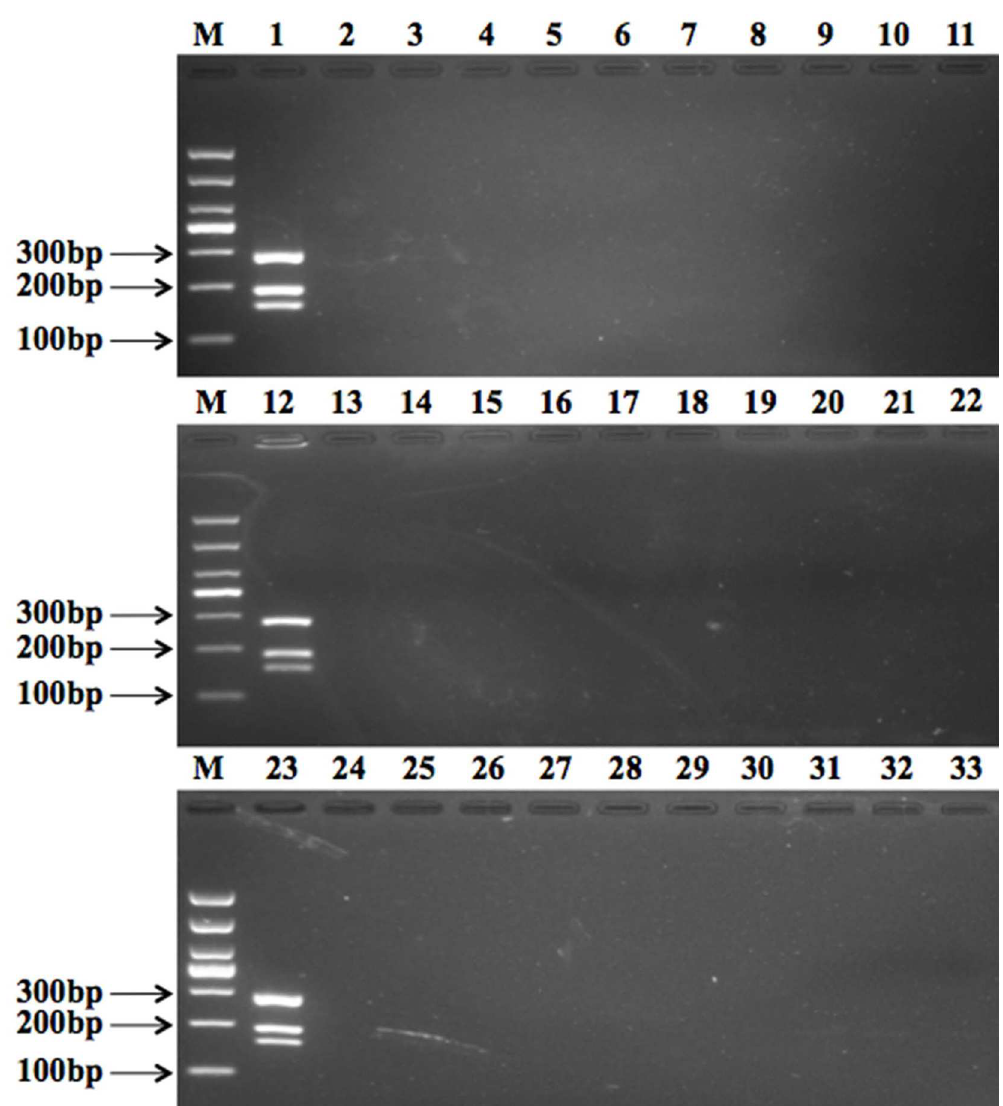
Fig 3. Primer specificity for L . monocytogenes , E . coli O157:H7, and S . aureus . Lane M: 2000 bp DNA marker; Lanes1, 12, and 23 show the PCR ampliconsspecific to L . monocytogenes (285 bp), E . coli O157:H7 (193 bp), and